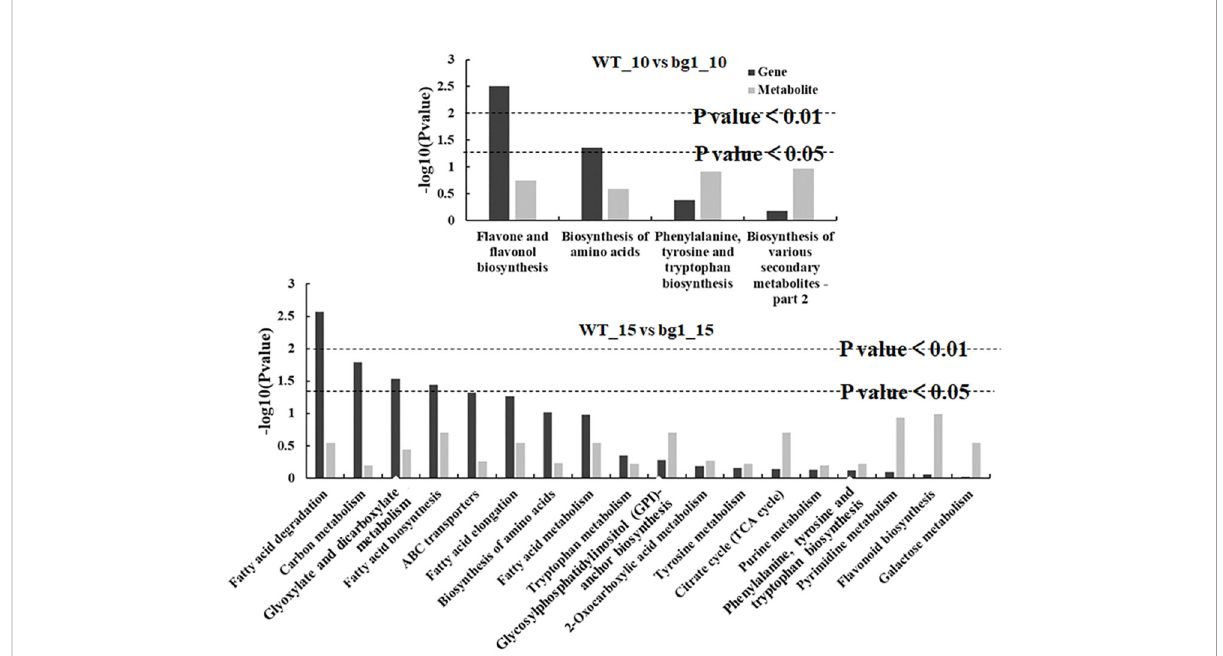
FIGURE 6 Pathways annotated with differential metabolites and differential